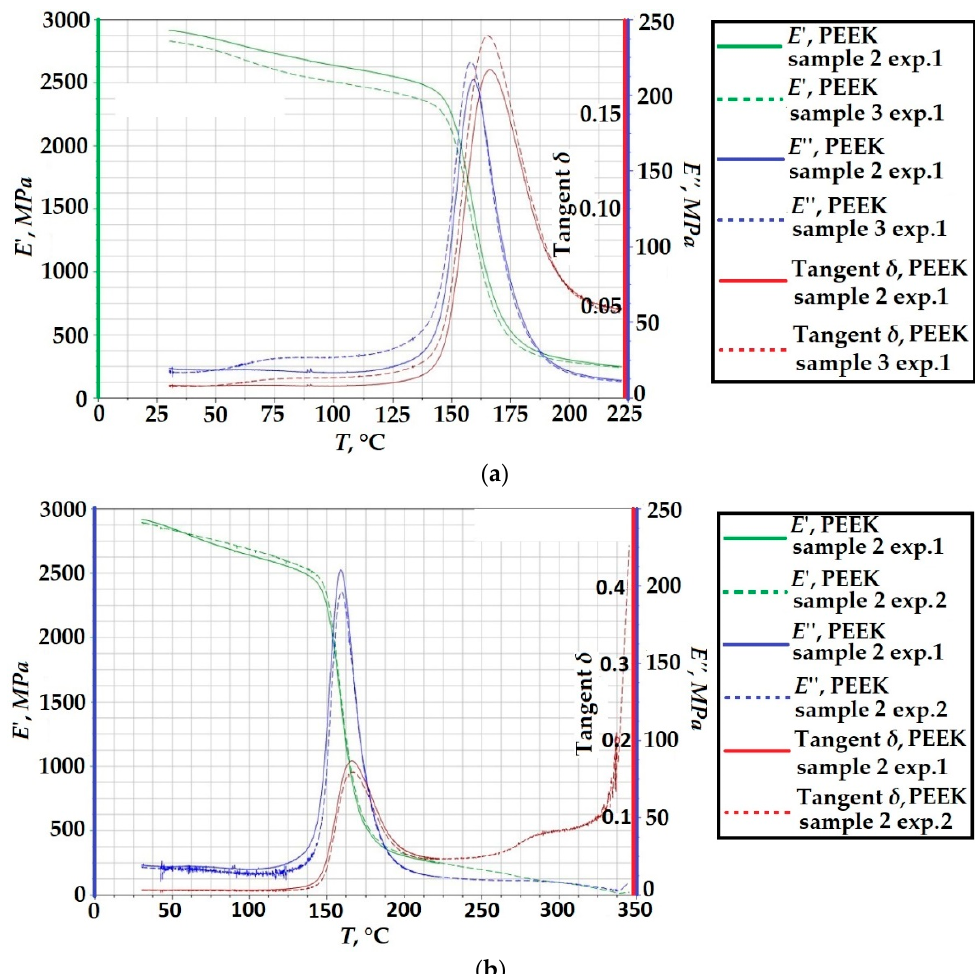
Figure 8. PEEK sample before and after DMA experiment.